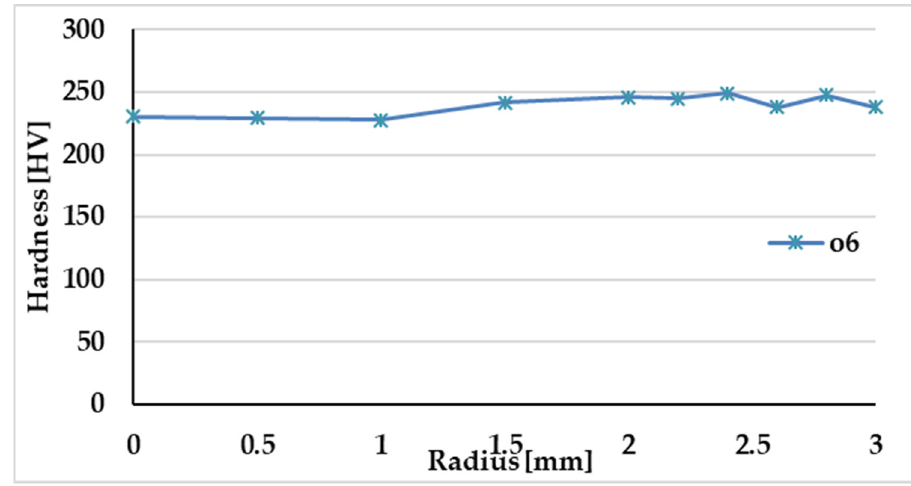
Figure 3. Hardness distribution along the cross-section of the reinforcement ϕ 6 (B500 B).